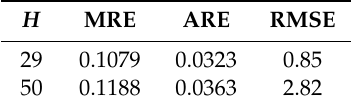
Table 3. The statistical indexes based onoptimized SVR model.